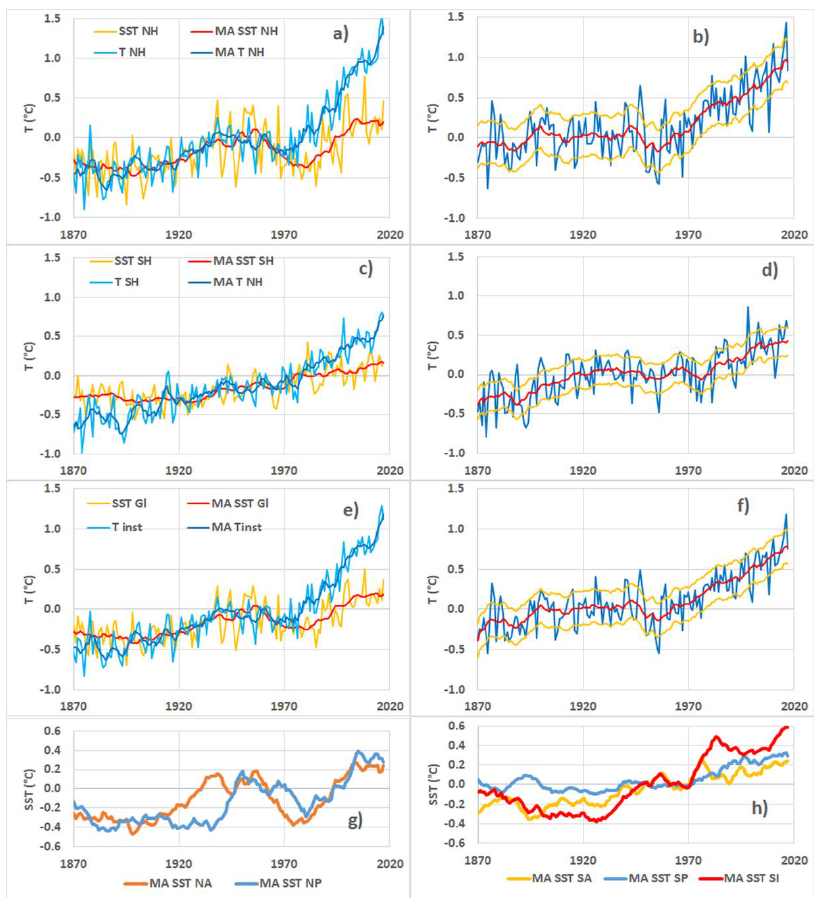
Figure 3. The instrumental temperature T ins t and the weighted sum of SST anomalies in the northern hemisphere ( a ), the southern hemisphere ( c ), and global ( e ). The Moving Average (MA) over 5 years is displayed — temperature response to anthropogenic forcing obtained by subtracting the climate component from T ins t in the northern hemisphere ( b ), the southern hemisphere ( d ), and global ( f ). The envelope T ins t ± σ is represented, where σ is the standard deviation (the 𝑙 2 norm of the residual obtained from the least squares method) — moving average over 13 years of the SST in the northern and southern hemispheres ( g , h ). Signals are centered over the period 1940 – 1970.